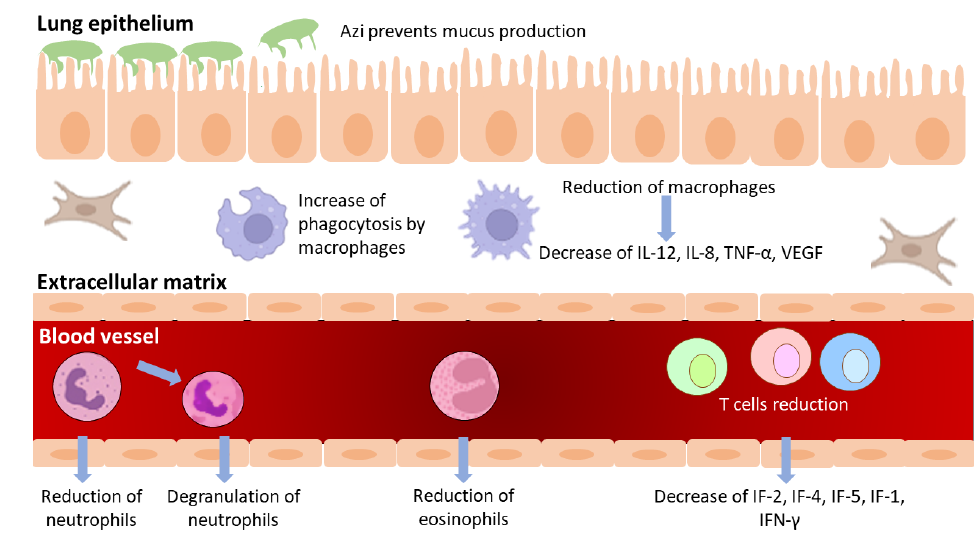
Figure 3. Immunomodulatory effects of azithromycin.